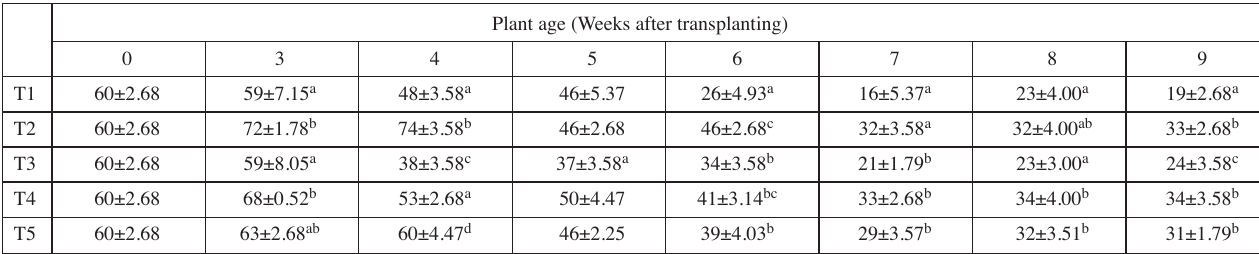
Tab. 5b: Effect of organic and inorganic fertilisers on Zn (mg/kg) of Solanum nigrum L. cultivated in the glasshouse Sodium